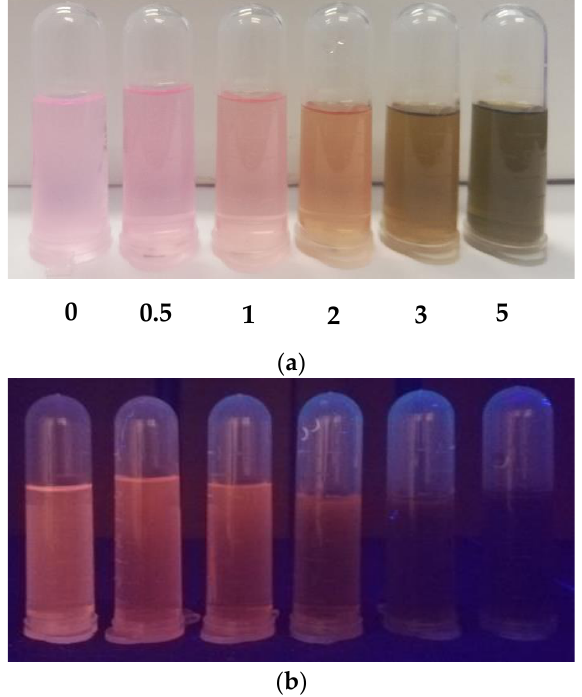
Figure 7. Photographs of P(MMA-co-RB) (0.5 mg/mL) under ( a ) visible light and ( b ) UV light at 365 nm after quenching treatment with Cu 2+ ion (0, 0.5, 1, 2, 3 and 5 mM).